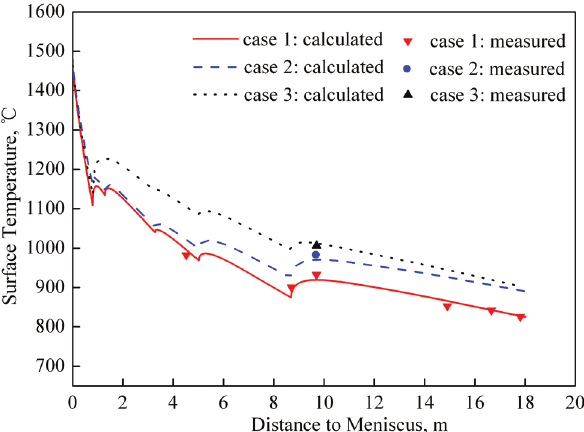
Fig. 4: Sample position of center equiaxed grain zone of the rectangular billet under different